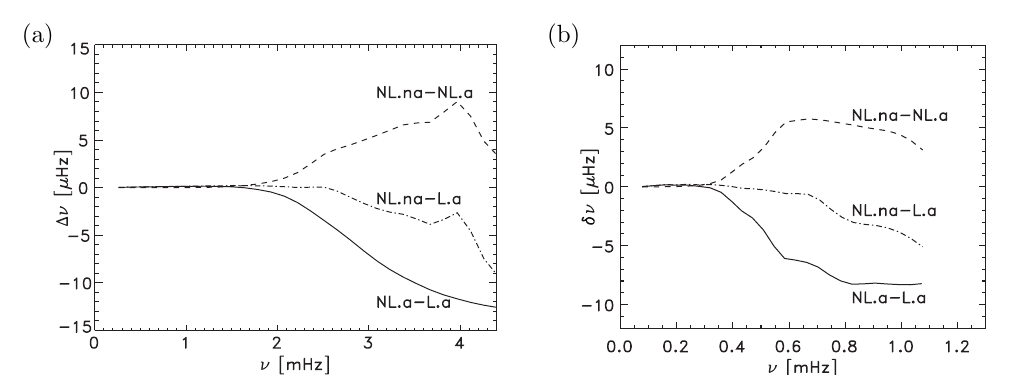
Figure 4: Frequency residuals between stellar models calculated with Gough’s nonlocal time-dependent mixing-length formulation (Section 3.3). (a) Results are shown for solar models: the solid curve (NL.a- L.a) shows the adiabatic radial oscillation frequency shifts, under the assumption 𝛿𝑝 t = 0, caused by the turbulent pressure 𝑝 t in the mean envelope. The dashed curve (NL.na-NL.a) is the frequency shift caused by nonadiabaticity and effects of including consistently 𝛿𝑝 t . The overall frequency shift (NL.na-L.a) is plotted by the dot-dashed curve. (b) Results are shown for models for the solar-like star 𝜂 Boo. The model calculations and line styles are as in panel (a). Images reproduced from Houdek